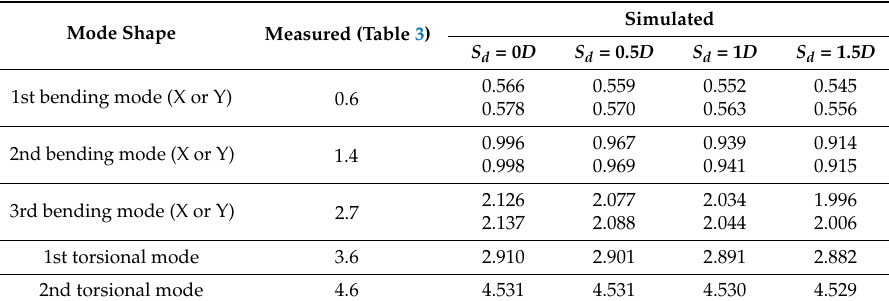
Table 7. Natural frequencies of met mast structure—case 2.